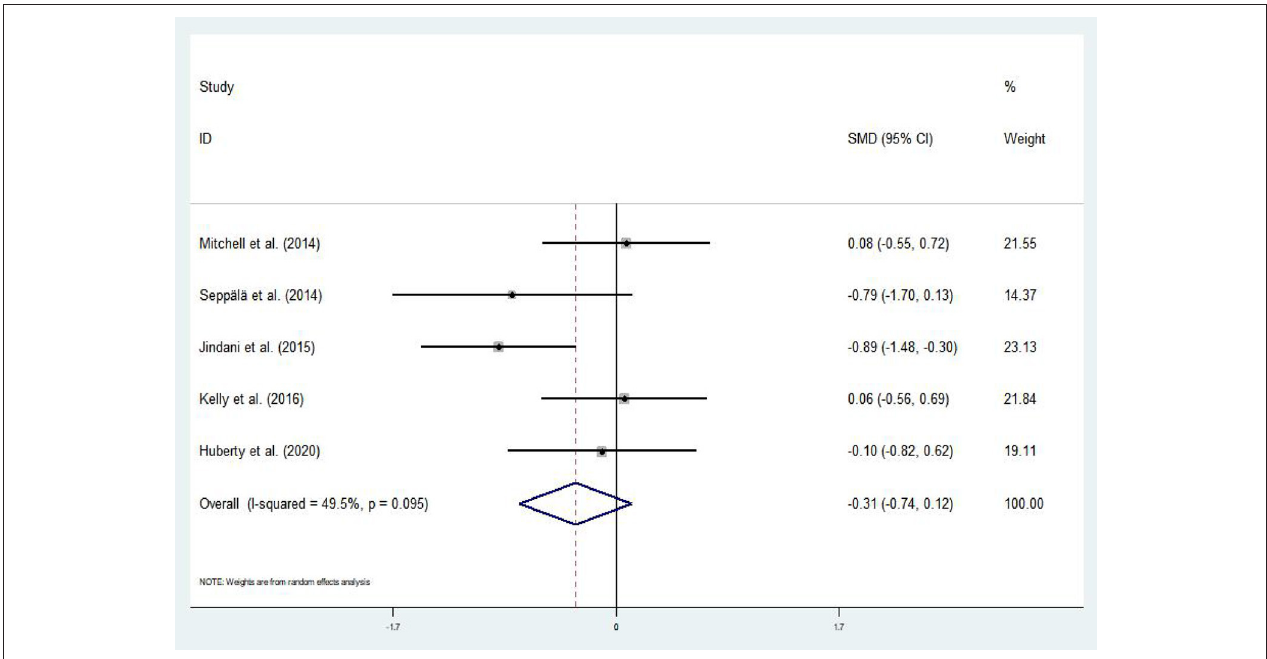
FIGURE 7 | Effect of mind–body exercises on